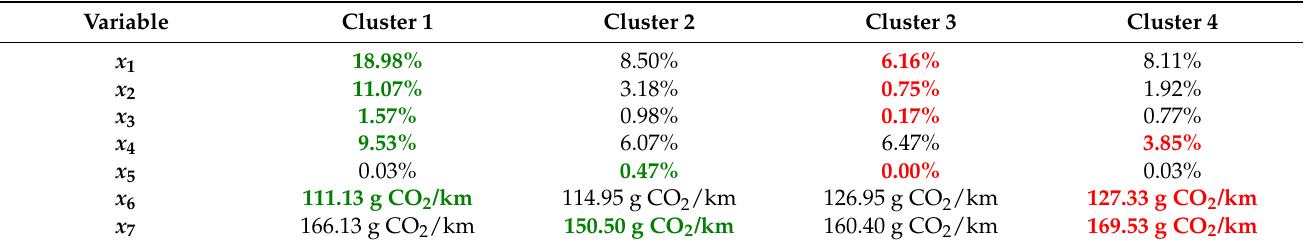
Table 5. Mean values of variables included in this study at the cross-section of four clusters (legend: green colour marks the highest values for stimulants and the lowest for destimulants; red colour denotes the lowest values for stimulants and the highest values for